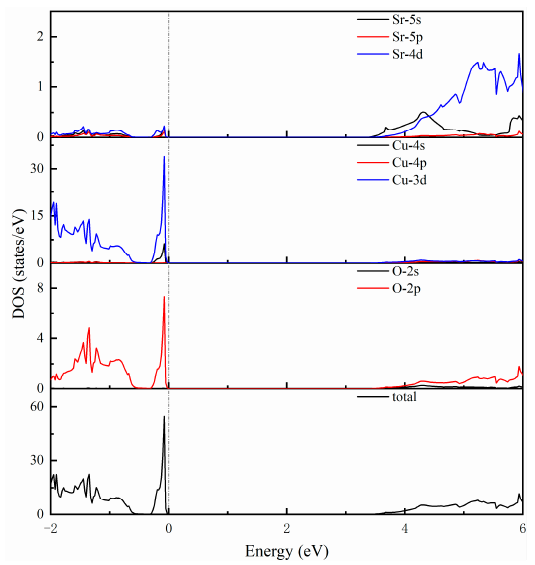
Figure 3. Calculated total and partial density of states using the HSE hybrid functional method.